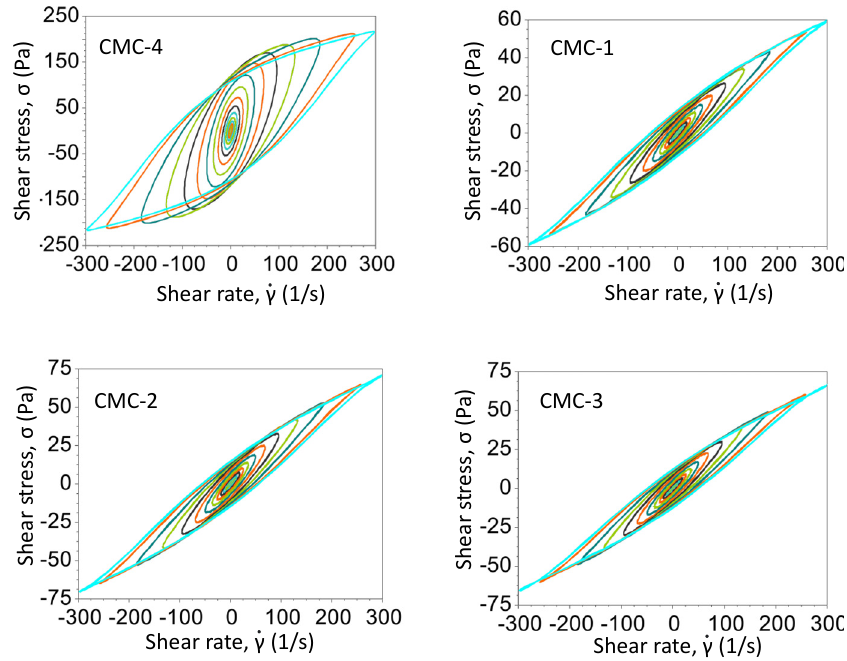
Figure 9. Lissajous–Bowditch curves for CMC-1, CMC -2, CMC-3, and CMC-4.